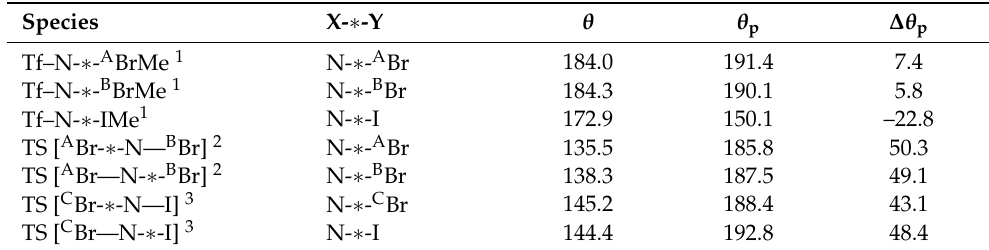
Table 3. The θ , θ p and ∆ θ p values for Tf–N- ∗ -BrMe, Tf–N- ∗ -IMe and TS [MeBr- ∗ -N(Tf)- ∗ -XMe], calculated under